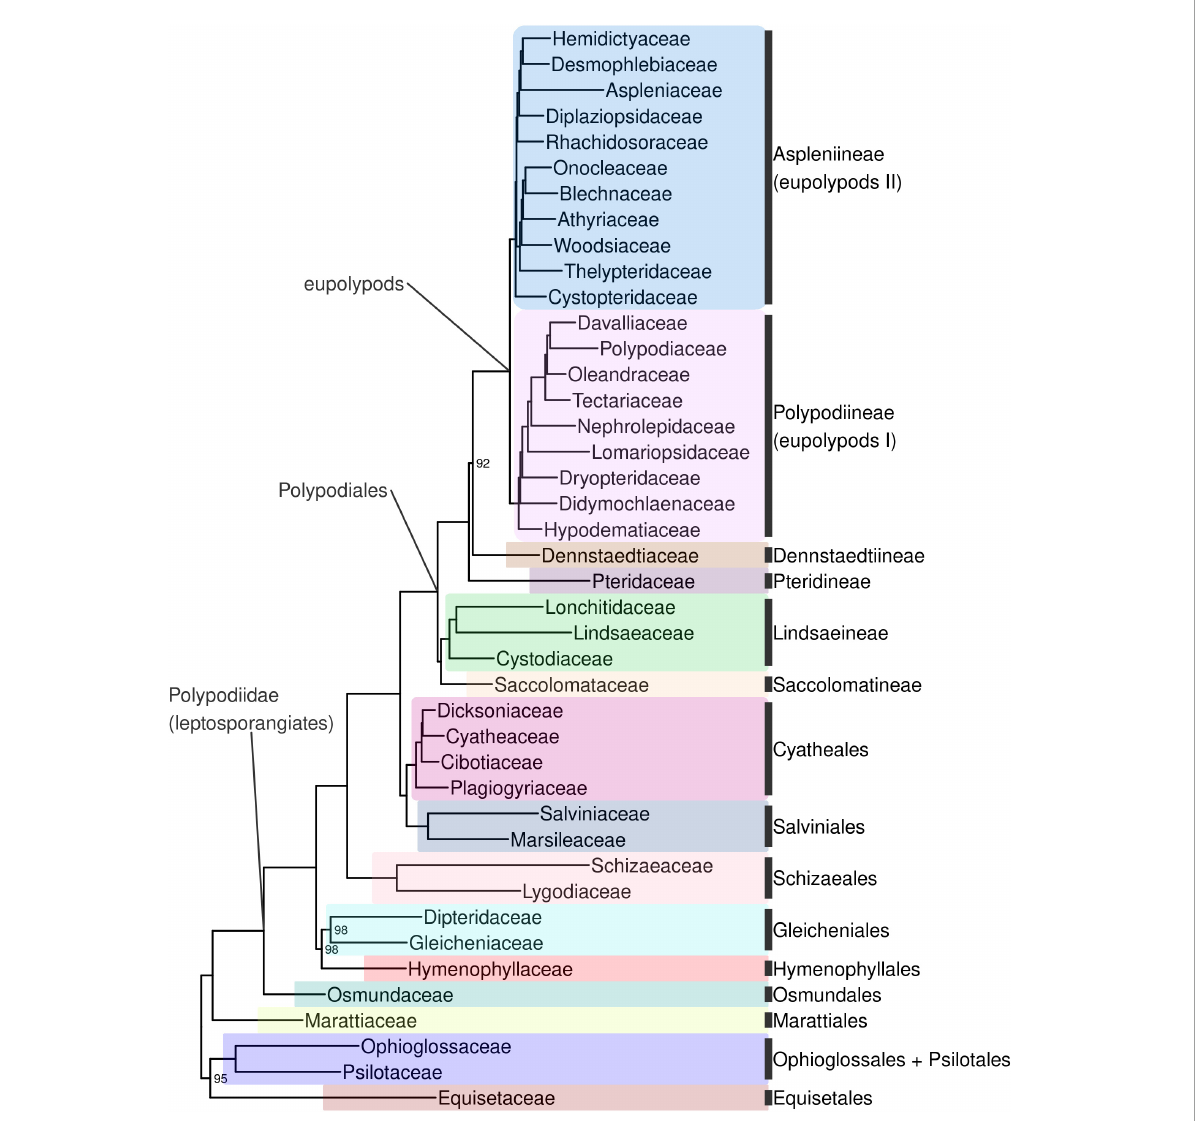
FIGURE4 Fern tree of life (FTOL) backbone phylogeny. One exemplar tip is shown per family (all families were found to be monophyletic; see Results). Ultrafast bootstrap support values (%) shown at nodes; unlabeled nodes are 100%. Outgroup (seed plants, lycophytes, bryophytes, and algae) not shown. Colors of major clades (orders or suborders) correspond to those used in Figure 3 . Taxonomy follows Pteridophyte Phylogeny Group I (2016); informal clade names in